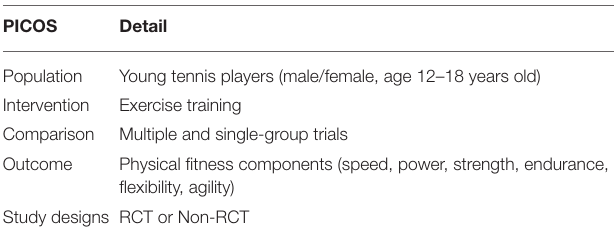
TABLE 1 | Inclusion criteria based on PICOS (population, intervention, comparison, outcome, and study